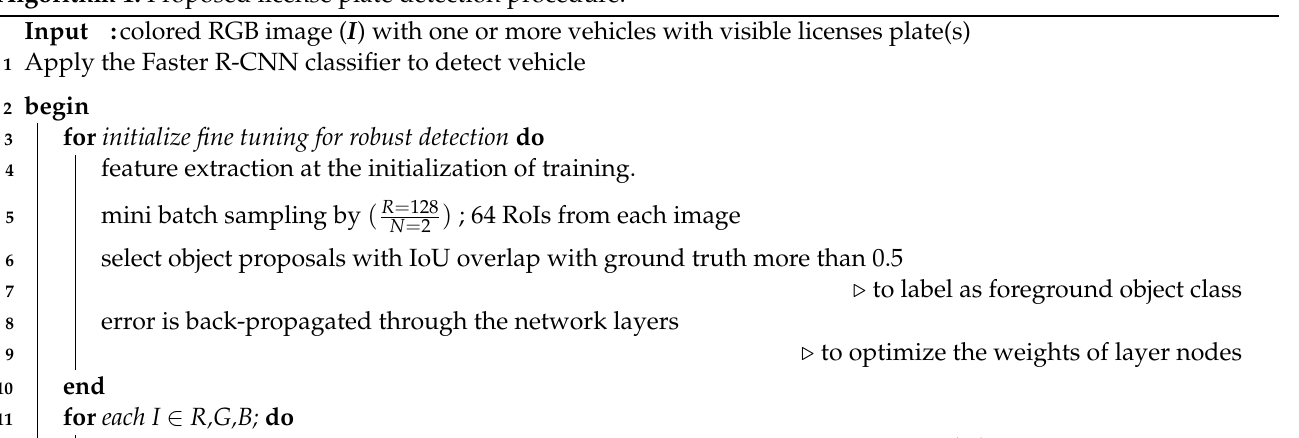
Algorithm 1: Proposed license plate detection